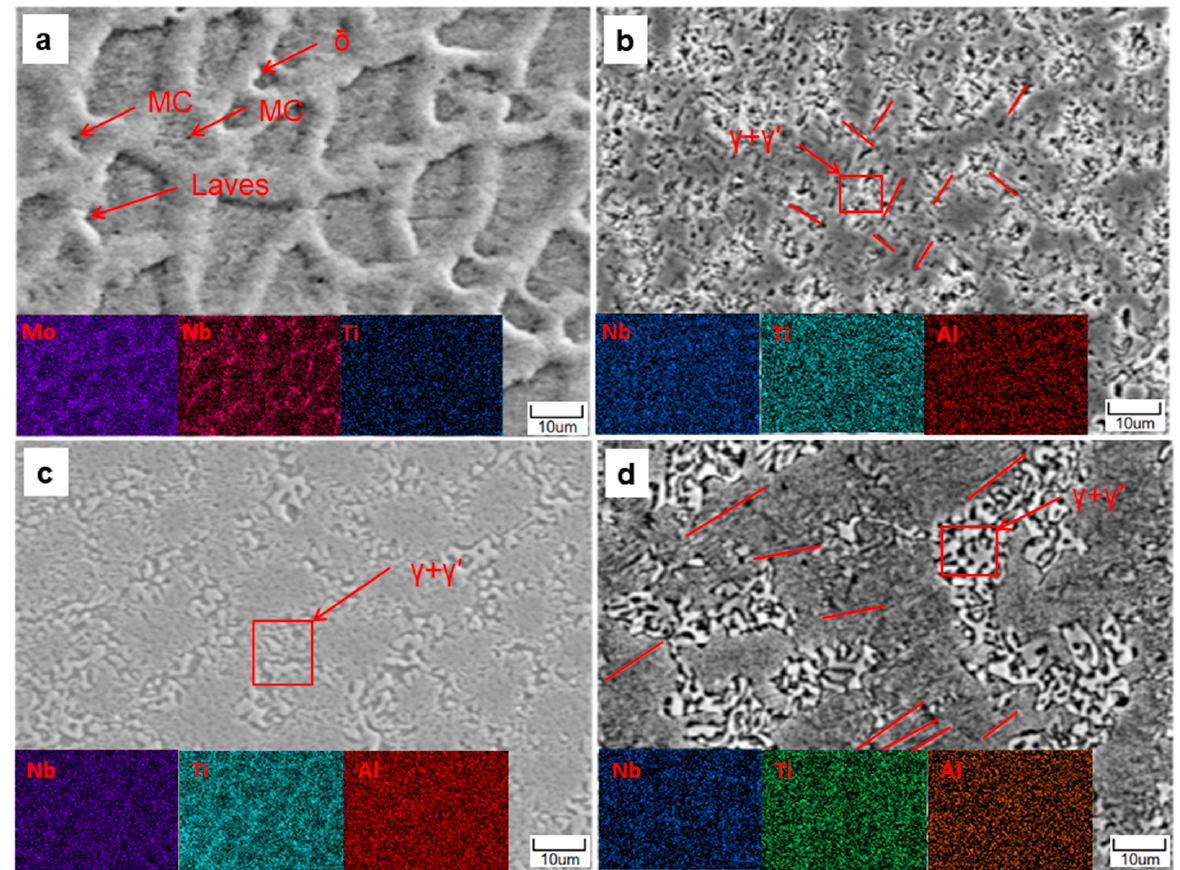
Figure 5. SEM and EDS images of the coatings surface after heat treatment (( a ) IN625, ( b ) 1#, ( c ) 2#, ( d ) 3#).